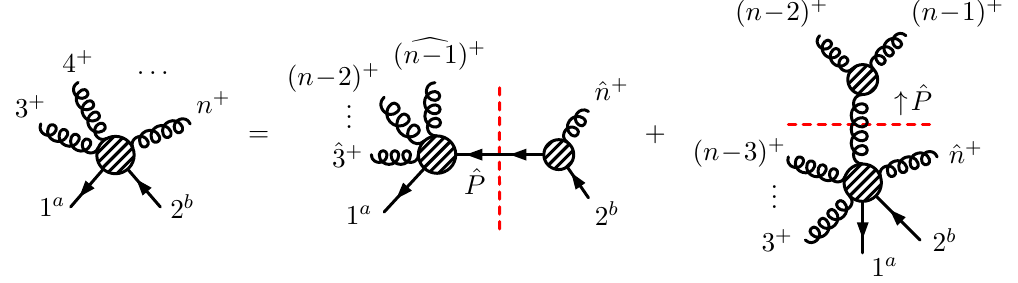
Figure 2 . Graphic representation of the BCFW recursion step (4.3) for A (1 a ; 3 + ; 4 + ; : : : ; n + ; 2 b